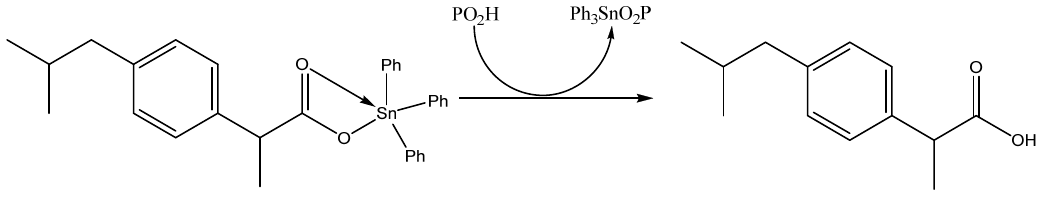
Figure 11. Organotin complexes as peroxide decomposers.